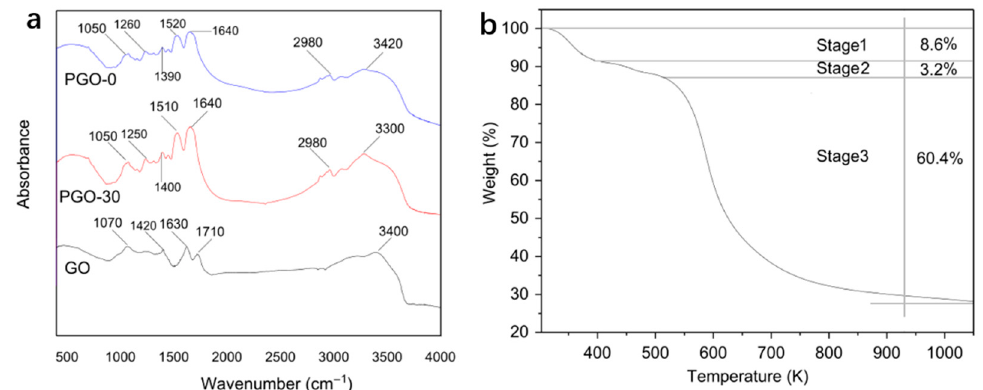
Figure 2. ( a ) FT-IR spectra of PGO-0, GO, PGO-30, and ( b ) TGA curves of PGO-30.